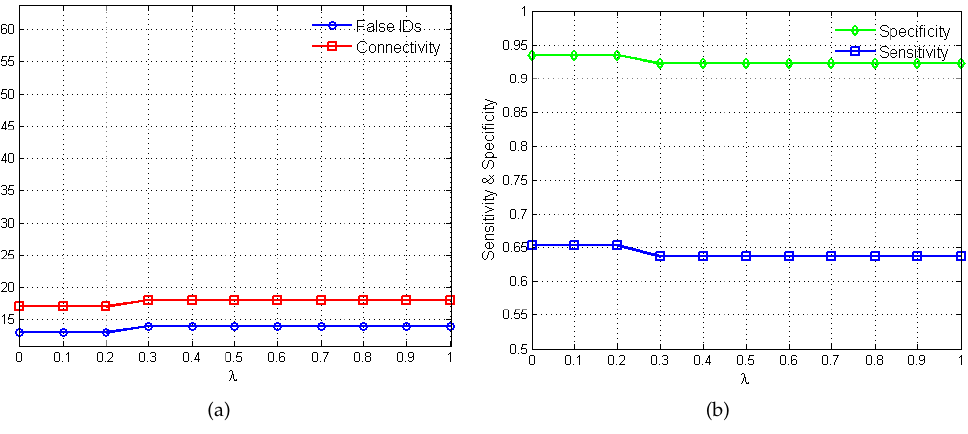
Figure 5. Variations in λ and the corresponding algorithm performance. ( a ) plot of λ versus total number of false identifications and net connectivity in percentages; ( b ) plot of λ versus sensitivity and